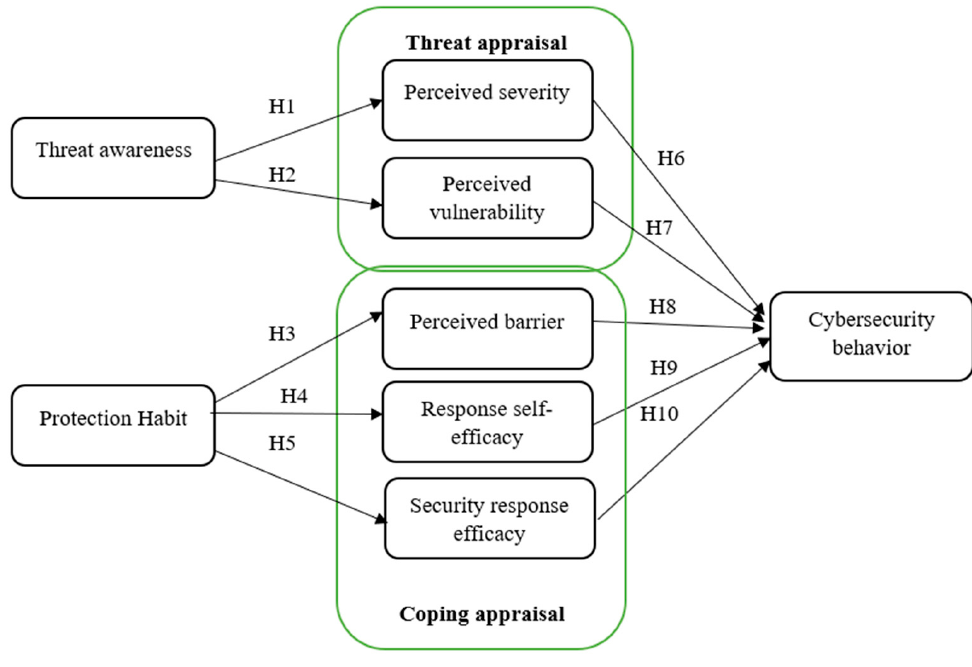
Figure 1. Research